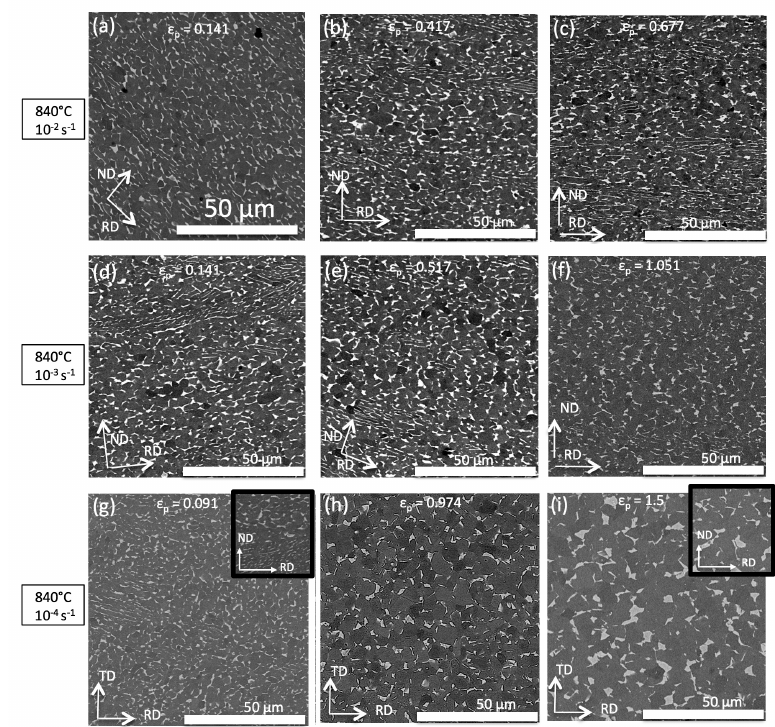
Figure 7. SEM images showing the evolution of the microstructure of the Ti6242 alloy during deformation at 840 ◦ C for several elongations and strain rates: 10 − 2 s − 1 ( a – c ); 10 − 3 s − 1 ( d – f ); 10 − 4 s − 1 ( g – i